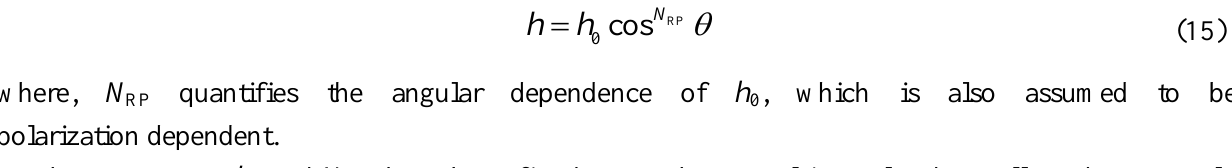
‘s measured over bare B and N parameters 0 RH